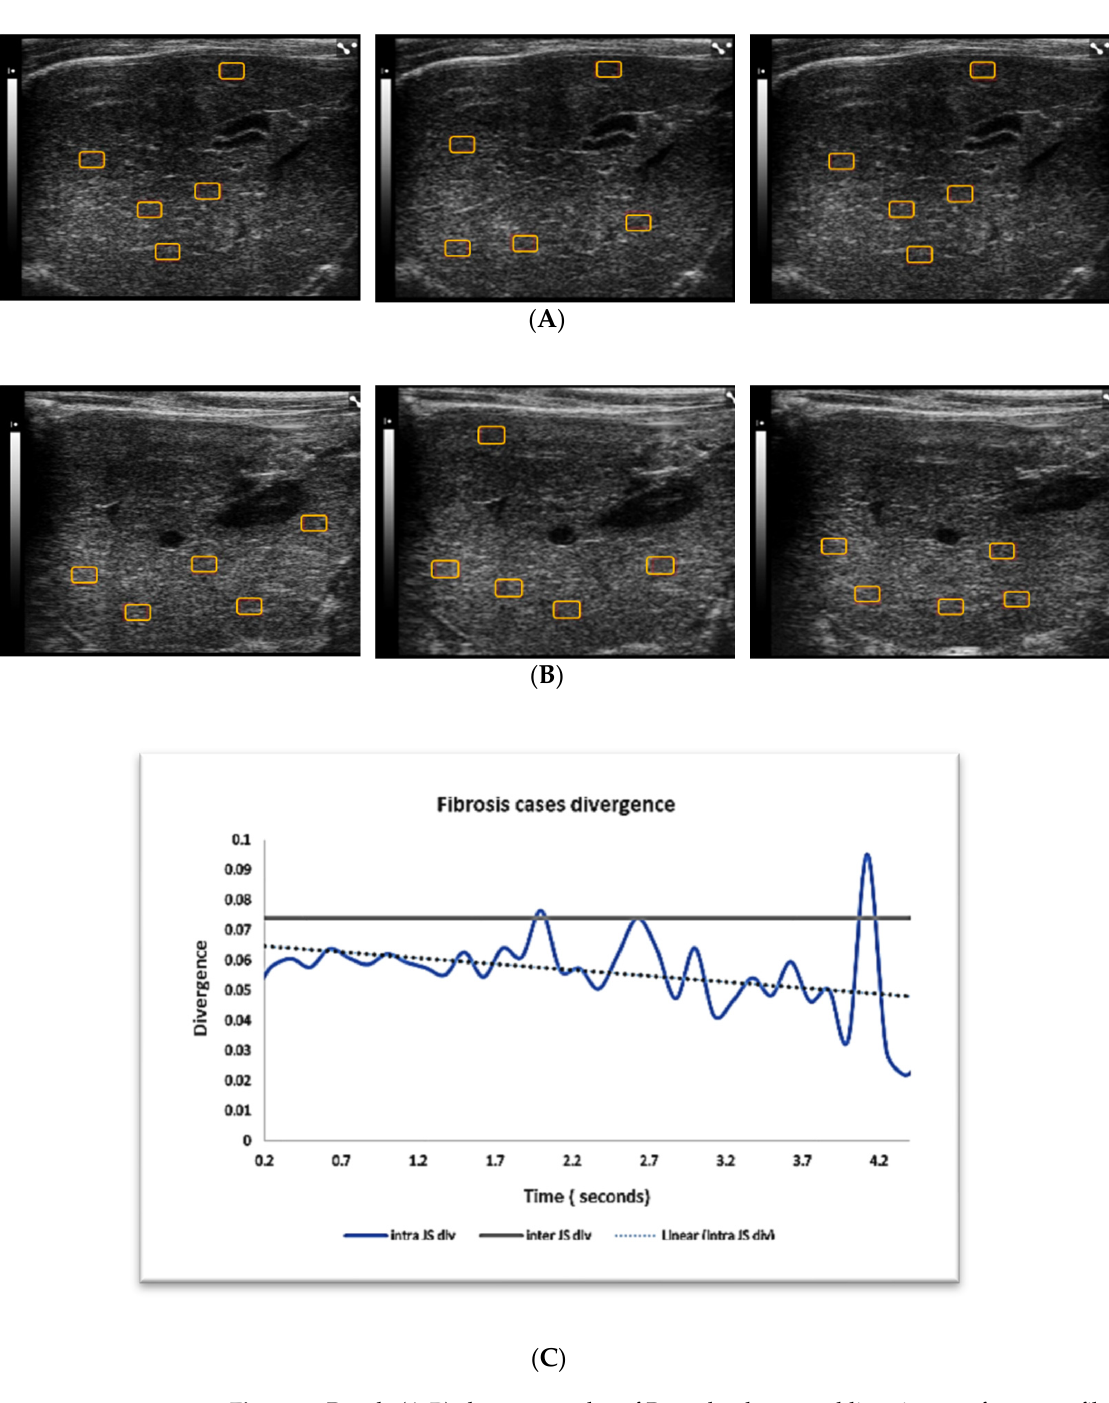
Figure 5. Panels ( A , B ) show examples of B-mode ultrasound liver images from two fibrosis cases. Panel ( A ) shows three sequential images from the same case with region of interests (ROIs) for quantitative analysis. Panel ( B ) shows three sequential images from another steatosis case. Panel ( C ) shows the intra- and intercase JS divergence for fibrosis cases in general. Intra- and intercase divergence for fibrosis cases is far apart, indicating that we cannot claim independence of intrasampling in these cases. Five to six regions of interests are placed (red rectangular boxes) on each image for quantitative analysis.